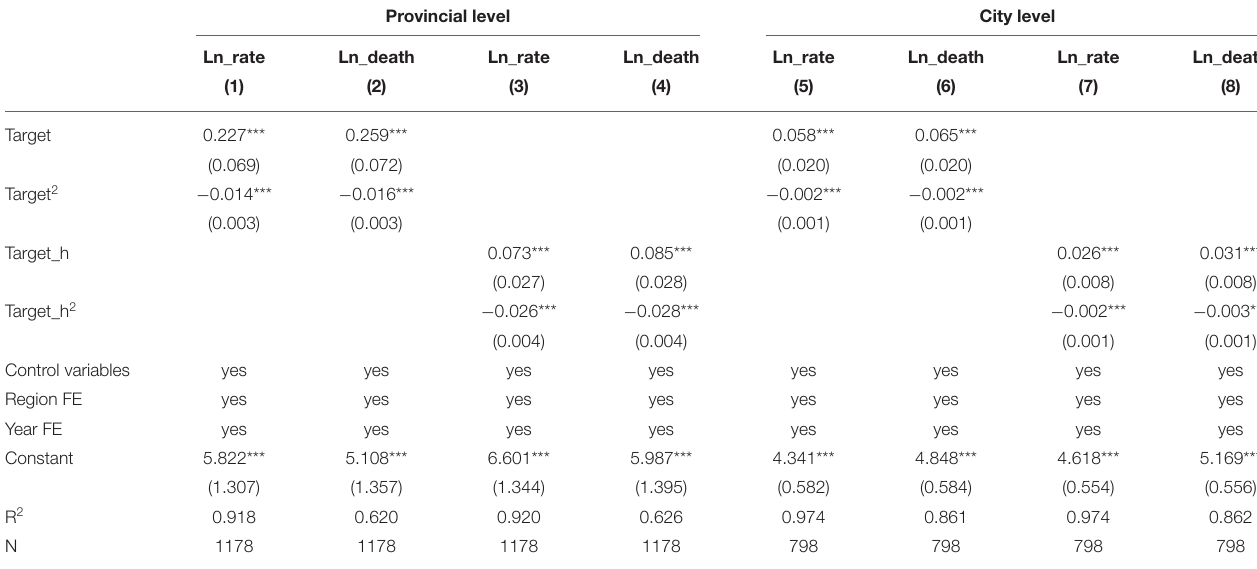
TABLE 6 | Robustness cheque: control the individual characteristics of officials.